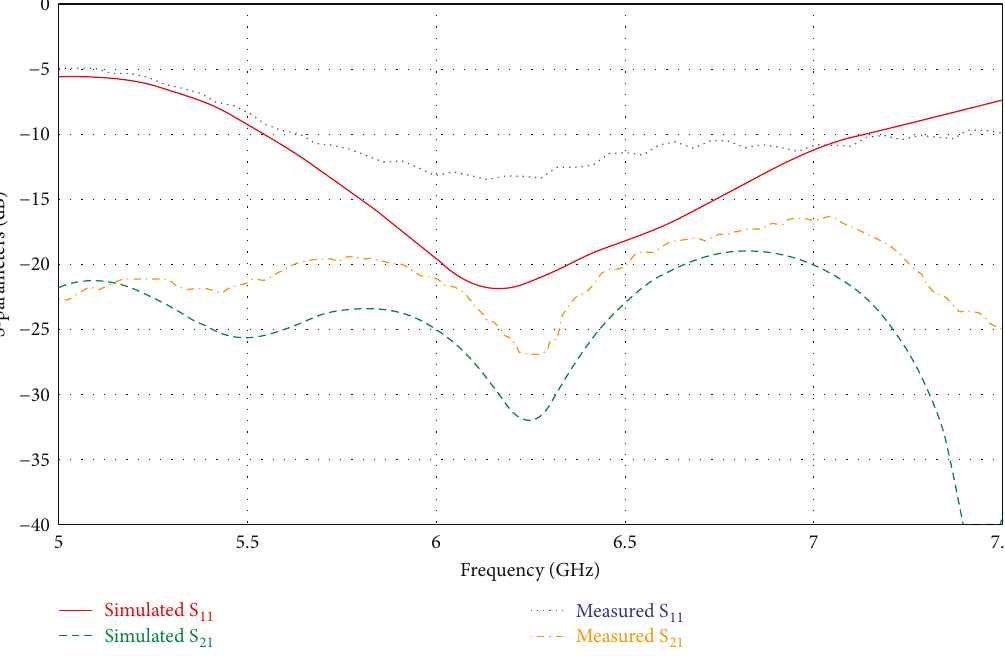
Figure 9: Comparison between simulated and measured S -parameters with the CSR matrix structure of the proposed MIMO